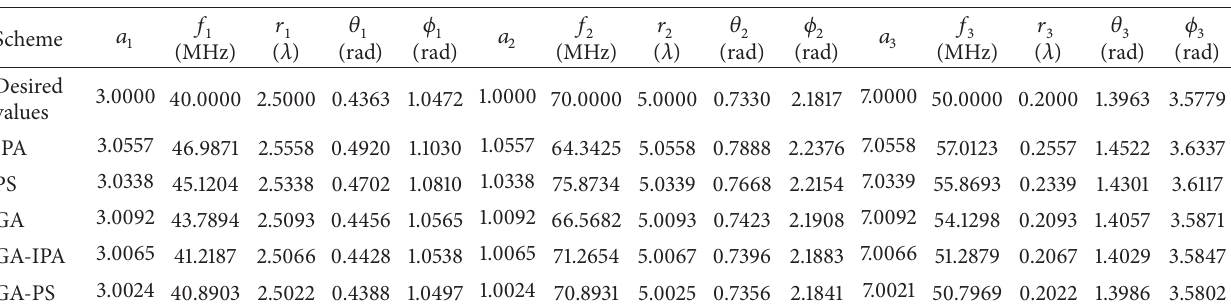
Table 3: Estimation accuracy of 3 sources using 13